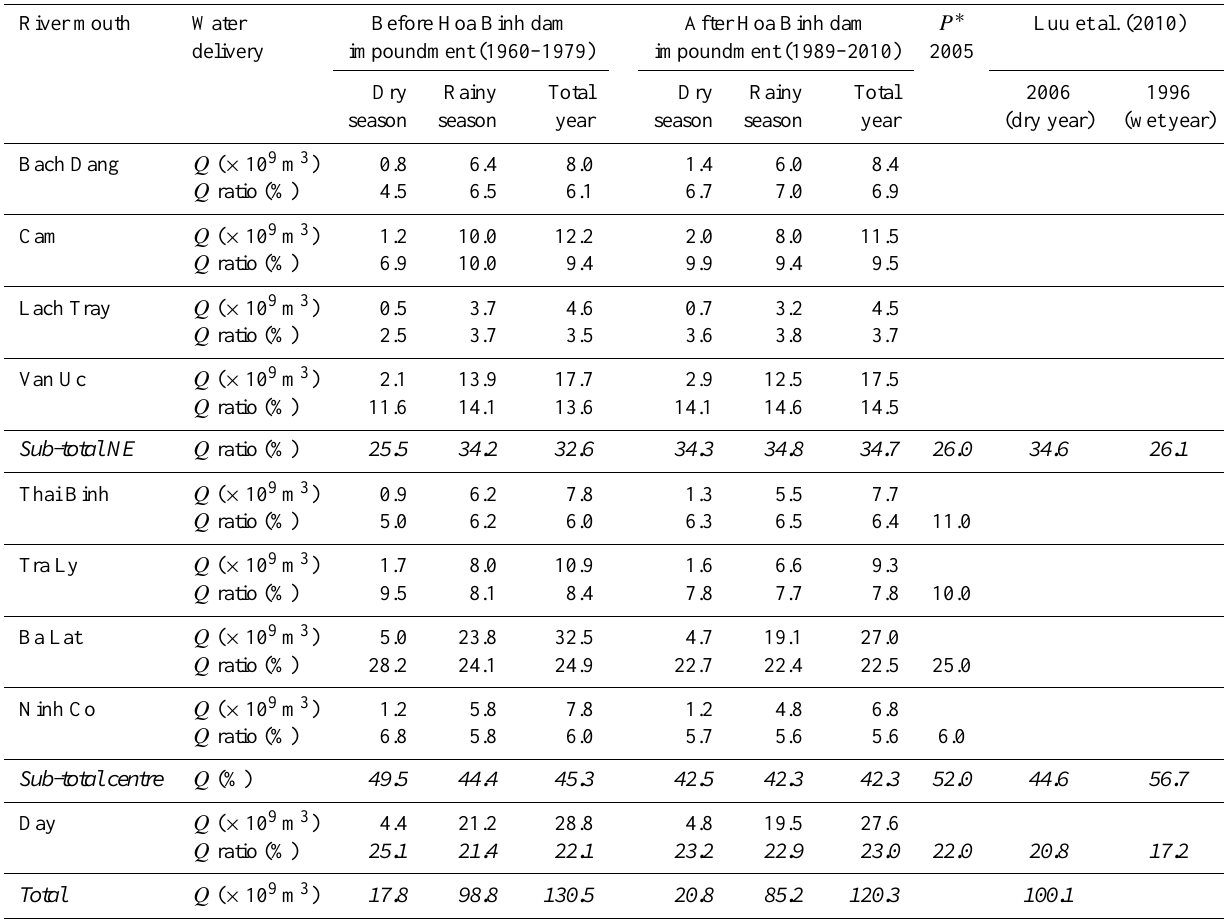
Table 3. Average water discharge in the nine distributaries of the Red River obtained from numerical simulations in the dry season (December–April), in the rainy season (June–October), and per year, before (1960–1979) and after (1989–2010) Hoa Binh dam impound- ment; comparison with previous estimates (Pruszak et al., 2005; Luu et al., 2010). River